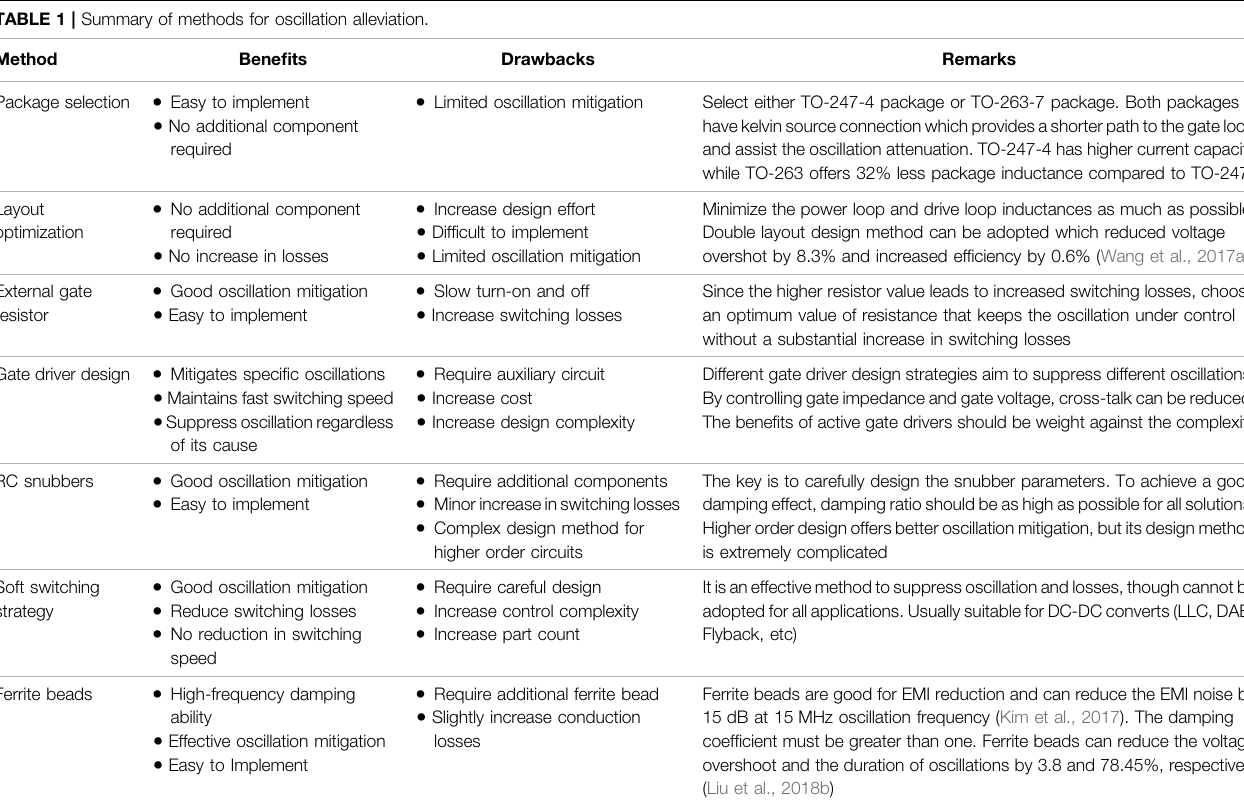
TABLE 1 | Summary of methods for oscillation alleviation. Method Bene fi ts